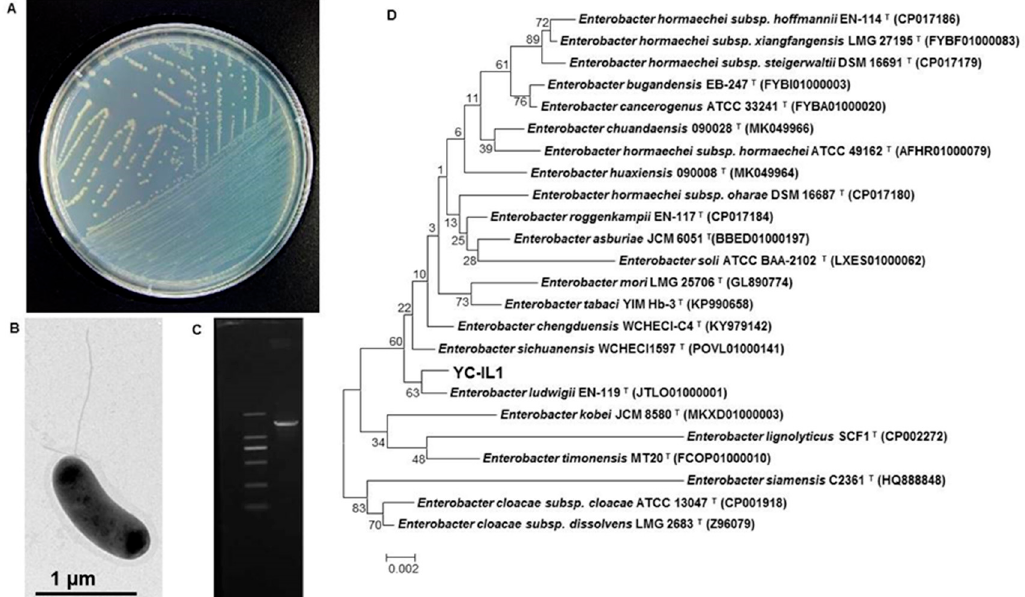
Figure 1. ( A ) The colonial morphology of strain YC-IL1 on TEM (Trace Element Medium) plate, ( B ) TEM investigation showing cell shape and lophotrichous flagellum, ( C ) amplified 16S rRNA gene of YC-IL1 compared with 2000 bp DNA leader, ( D ) phylogenetic tree of Enterobacter spp. YC-IL1 with closely related strains.